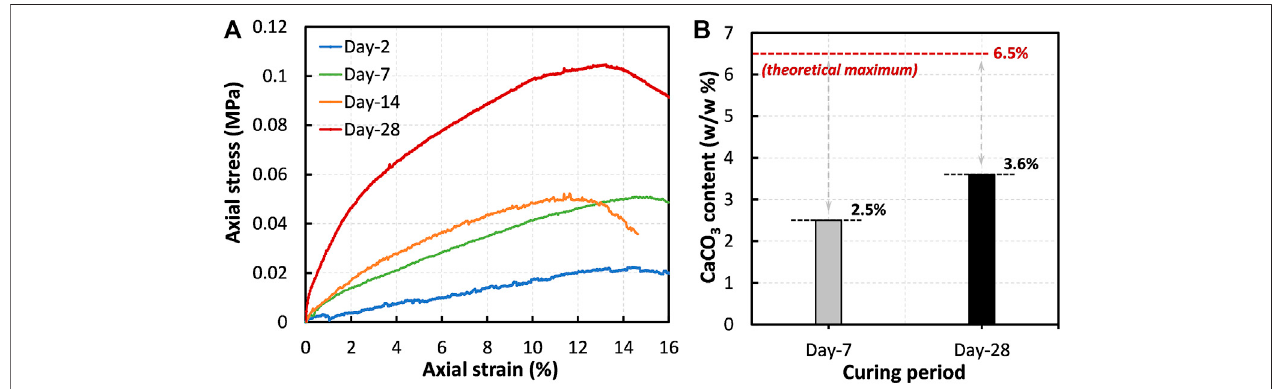
FIGURE 9 | (A) Effect of curing duration on strengthening of the treated amorphous peat: comparison between the cases 16 – 19 and (B) comparison of the precipitated CaCO 3